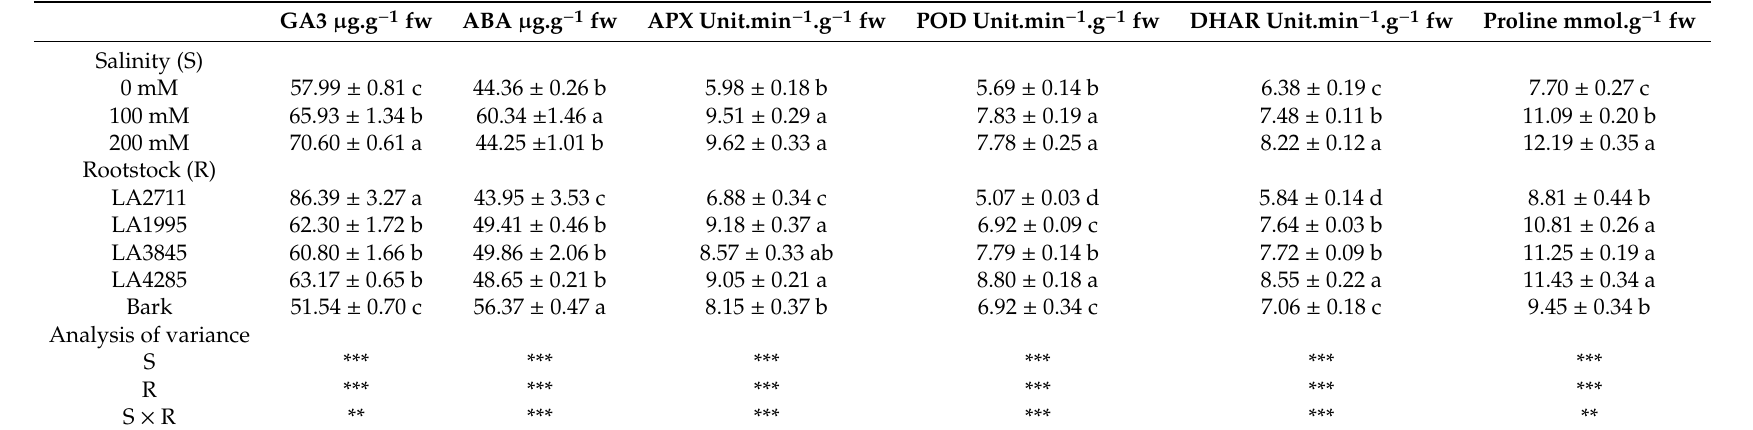
Table 11. E ff ect of salinity treatments, rootstocks and their interactions on hormones of tomato